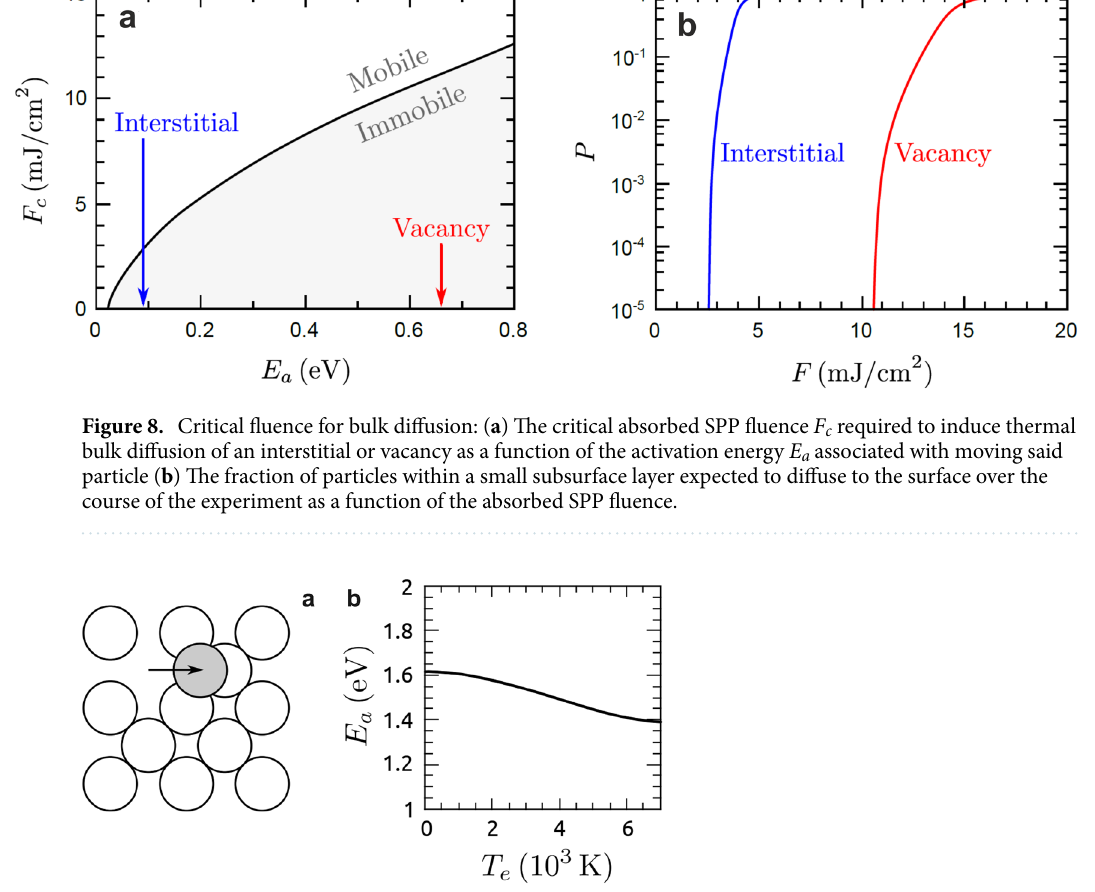
Figure 9. Bond softening: ( a ) scheme for modeled process ( b ) activation energy for process shown in panel ( a ) in dependence of electron temperature T e